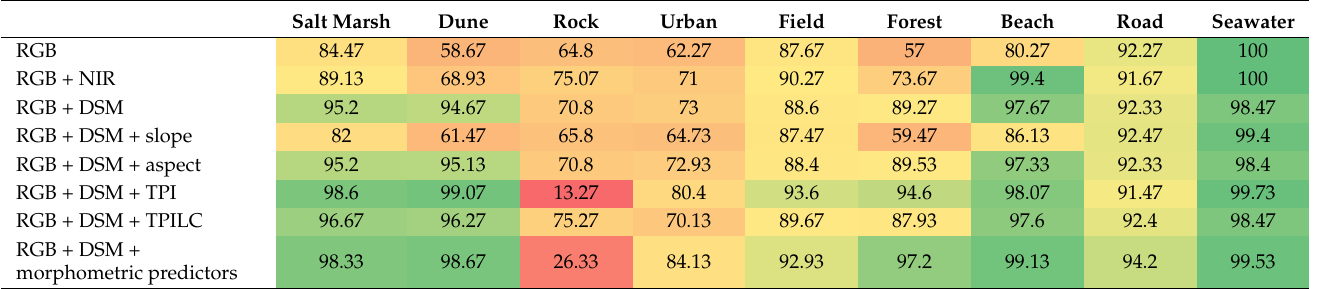
Table 3. Producer accuracy (in %) from confusion matrix using the maximum likelihood classifier for the salt marsh, dune, rock, urban, field, forest, beach, road, and seawater classes. Salt Marsh Dune Rock Urban Field Forest Beach